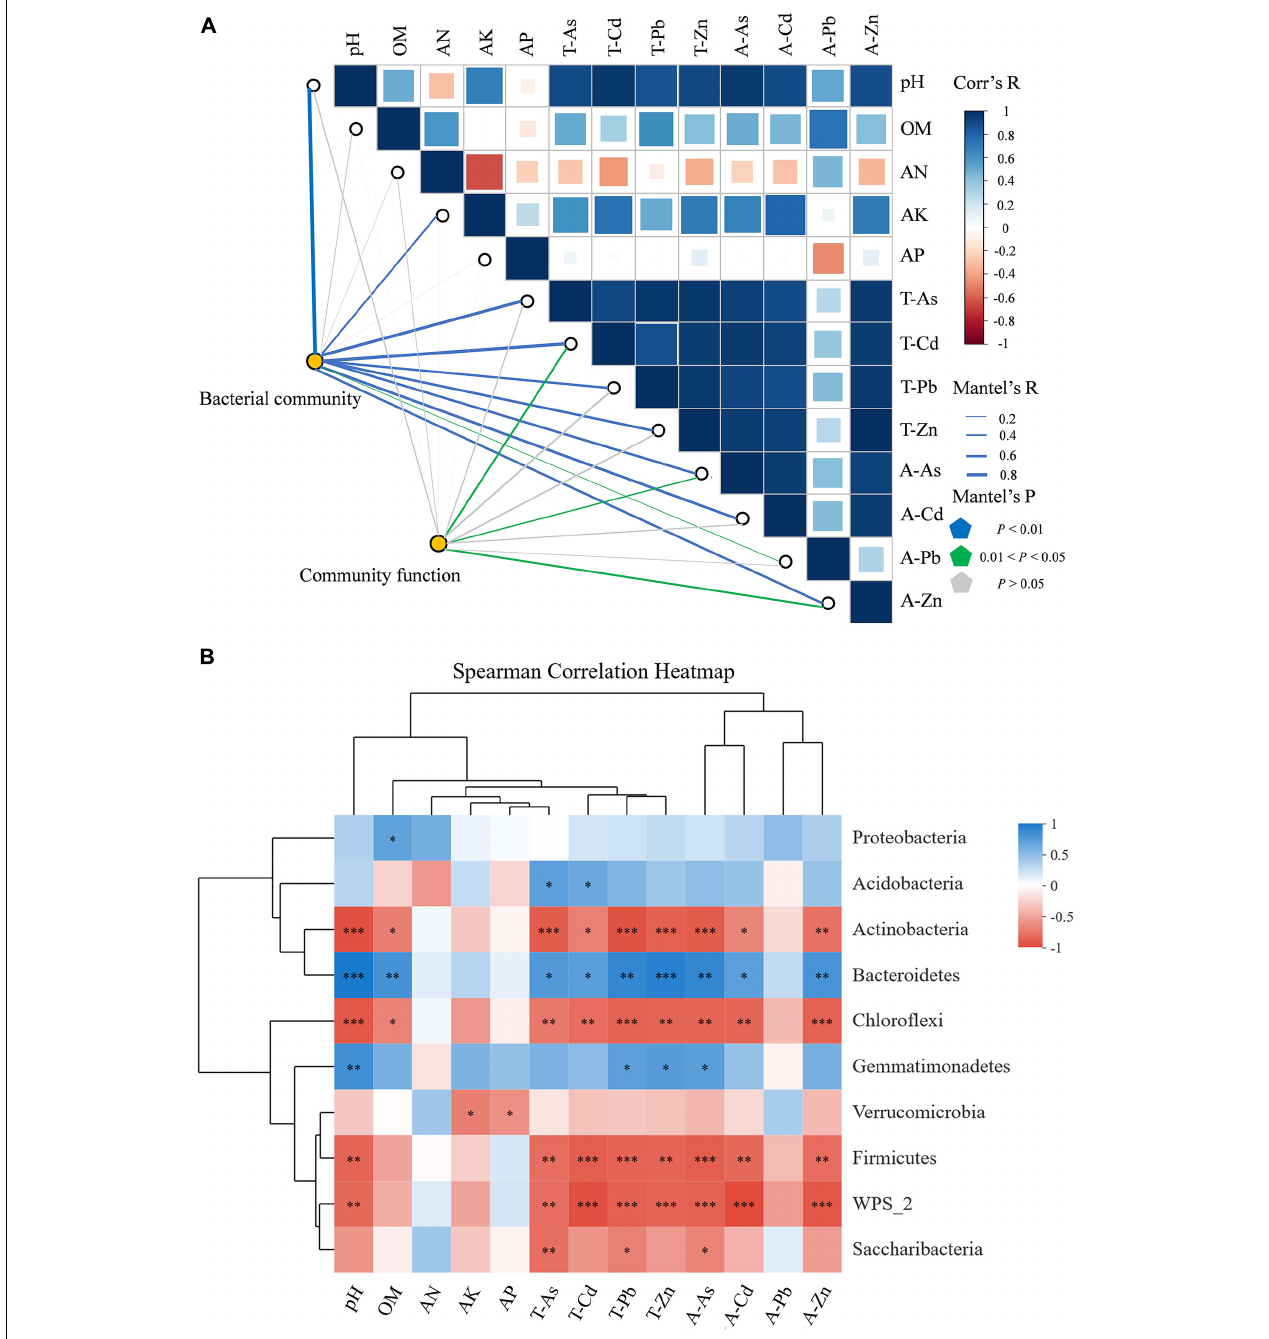
FIGURE 7 | (A) Pairwise comparisons of ecological drivers, with a color gradient denoting the Spearman’s correlation coefficients. The structure of the bacterial communities was correlated with each ecological driver by partial Mantel tests, as well as by microbial function. Curve width and color represent the correlation coefficients of the partial Mantel tests; blue in the figure indicates p < 0.01, purple indicates 0.01 < p < 0.05, and gray indicates p > 0.05. (B) Heatmap of Spearman’s rank correlation coefficients between the four sites for the relative abundances of bacterial phyla, including the relative abundances (%, n = 3) of the top 10 microbial phyla. Note: Horizontal row represents physiochemical properties of the soils and the metals/metalloid information; the vertical row represents information on the abundance of the microbial communities; red represents negative correlation, blue represents positive correlation, a darker color indicates a higher correlation; the p value is the correlation test result; * p < 0.05, ** p < 0.01, *** p < 0.001. T-As, total concentration of arsenic; T-Cd, total concentration of cadmium; T-Pb, total concentration of lead; T-Zn, total concentration of zinc; A-As, available content of arsenic; A-Cd, available content of cadmium; A-Pb, available content of lead; A-Zn, available content of